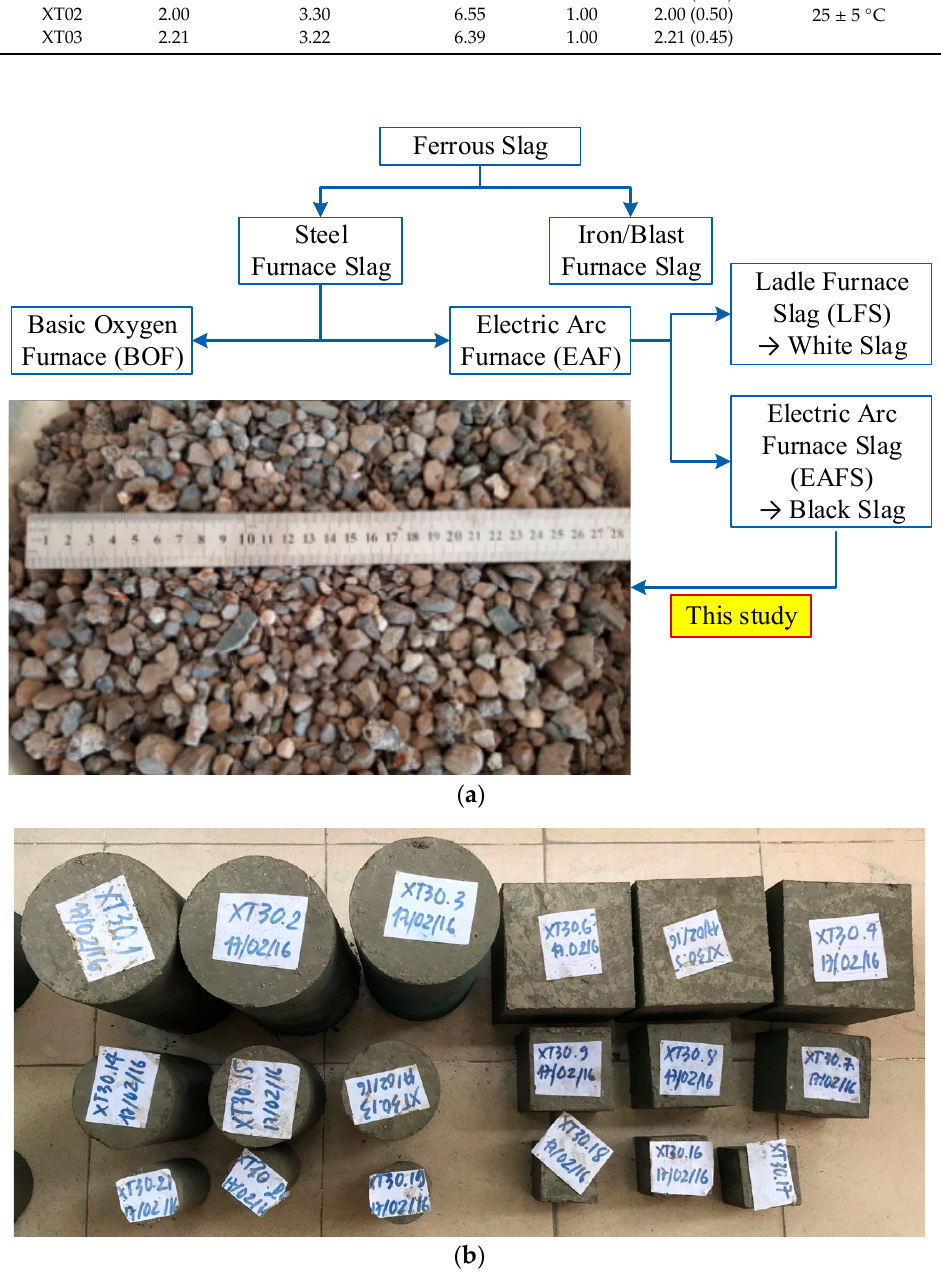
Figure 2. Photos of steel-slag and prepared specimens. ( a ) Steel-slag used as coarse aggregate. ( b ) Specimens with different sizes and shapes. Table 2. Particle size distribution of fine aggregate and coarse aggregate.